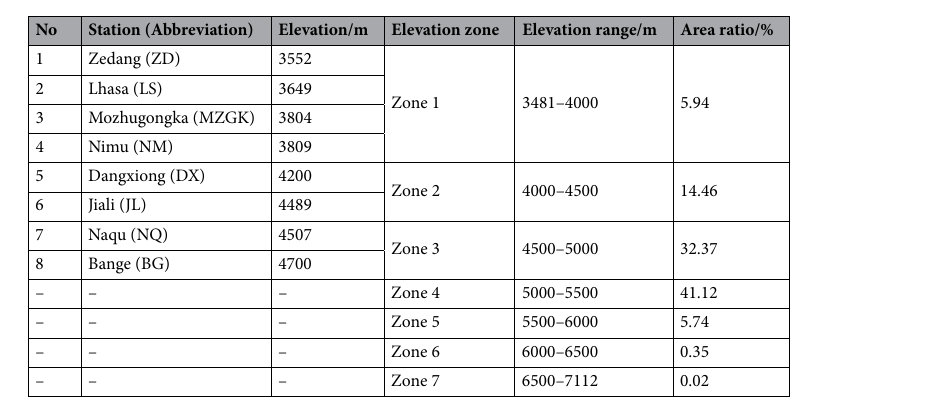
Figure 1. The elevation zones and stations in the LRB. The basin was divided into seven elevation zones at 500 m intervals (Details in Table 1). Based on the 30 m DEM, the elevation-area curve of the LRB was plotted in ( b ), and the mean elevation of each elevation zone is marked on the curve. Eight MET stations were also marked on the curve according to their elevation. In ( a ) was generated with ArcGIS 10.6 (https:// www. esri. com/ en- us/ home).